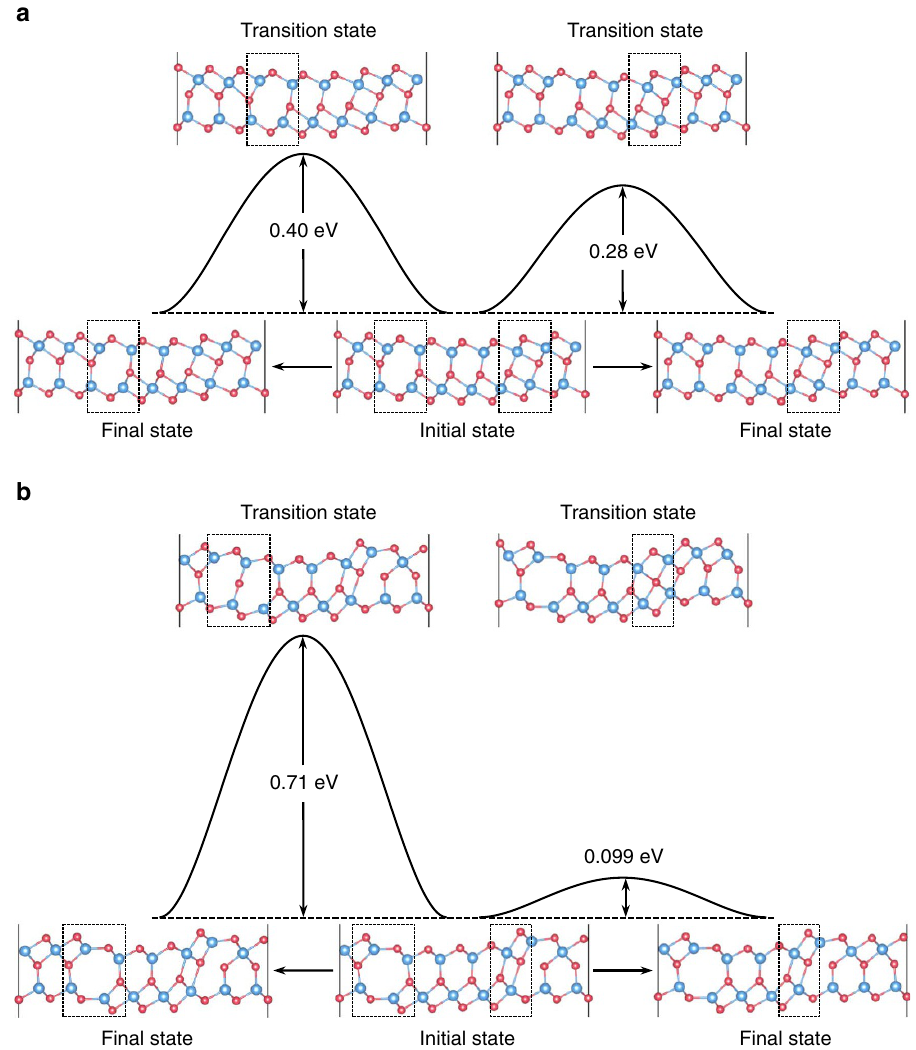
Figure 4 | Kinetic pathways of domain wall motion. Initial states containing four possible domain wall structures between two ferroelectric domains of one quintuple layer In 2 Se 3 in the FE-ZB 0 phase with opposite electric polarizations are shown in a , b (at the bottom centre), along with the energy profiles, final states (at the bottom left and right), and transition states (at the top) of the kinetic pathways involved in the motion of the domain walls. The black dashed squares indicate the positions of the domain